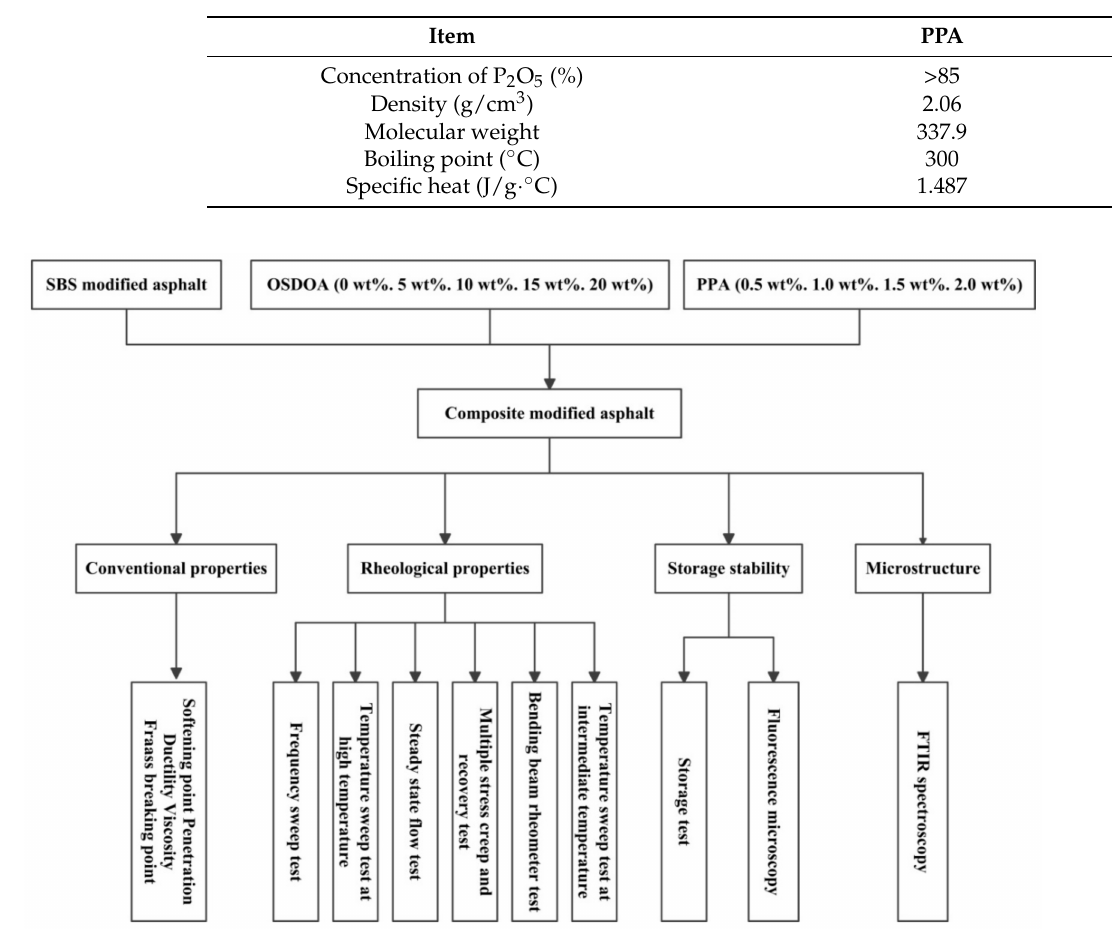
Table 4. Technical indexes of PPA.